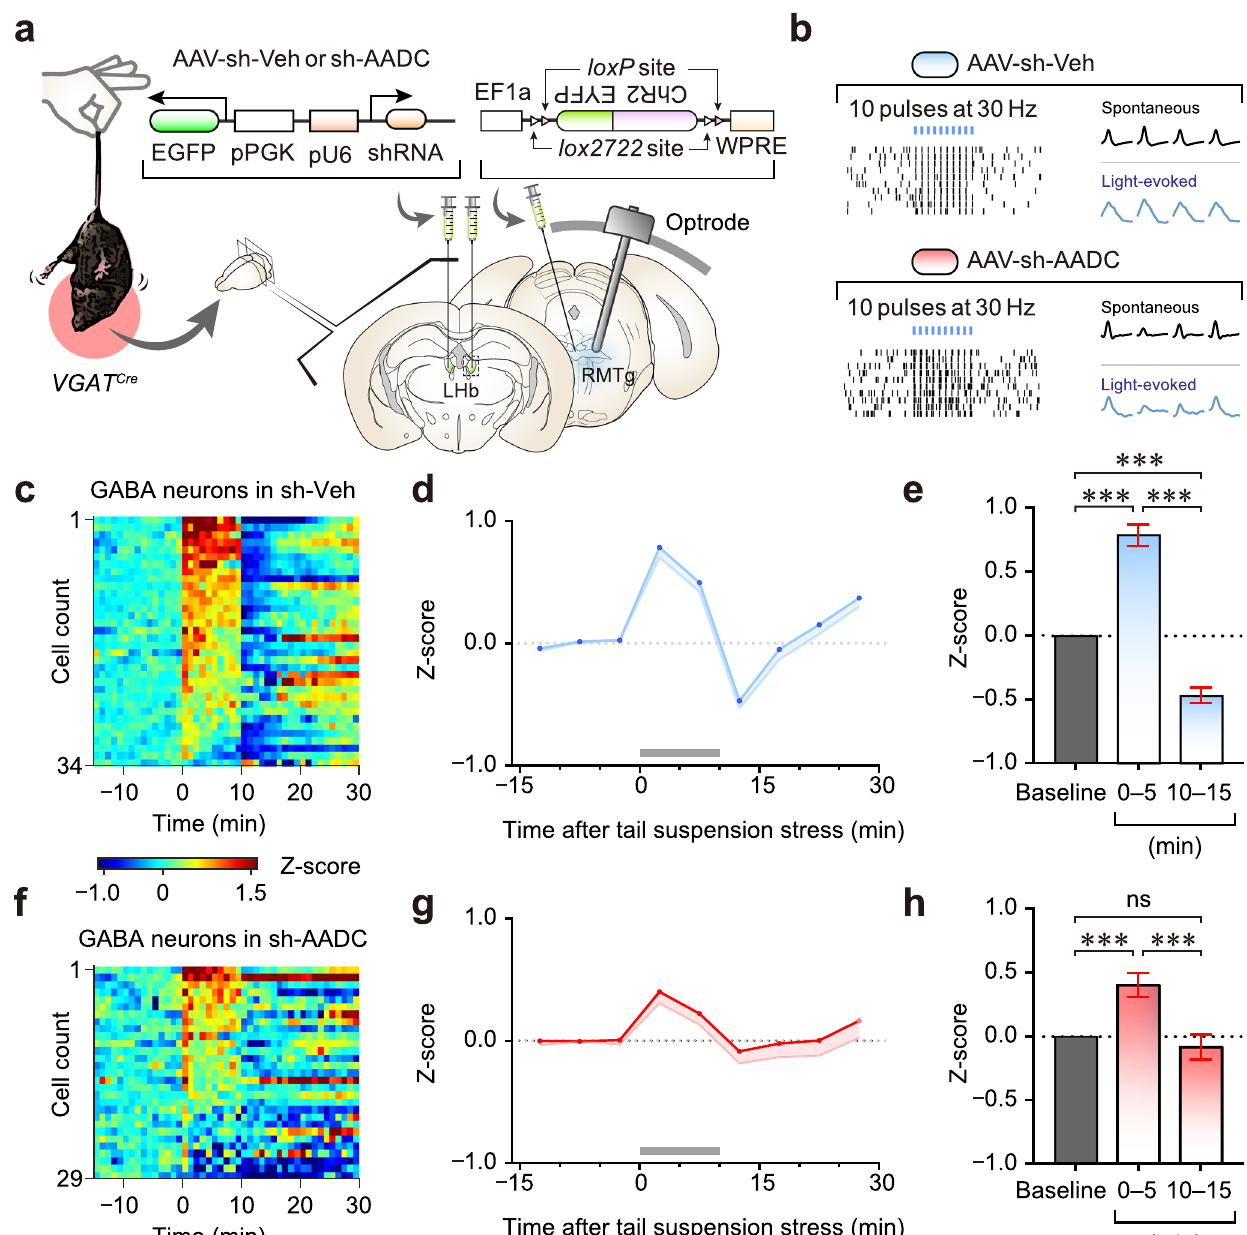
Fig. 6 | LHb D-neurons regulate RMTg GABAergic responses to acute stress through trace aminergic signalling. a Schematic of in vivo recording of RMTg GABAergicneuronalactivityundertailsuspensionstress. b Opticalidenti fi cationof ChR2-expressing GABAergic neurons in the RMTg. The raster plots of two repre- sentative GABAergic neurons from control and AADC-knockdown mice. c , f Heat- maps of the average normalised fi ring of GABA neurons (5-min bins) in control ( c ) and AADC-knockdown ( f ) mice. Tail suspension stress was given for 10min from time 0. d , g Normalised fi ring rates of all GABAergic neurons in control ( d ) and